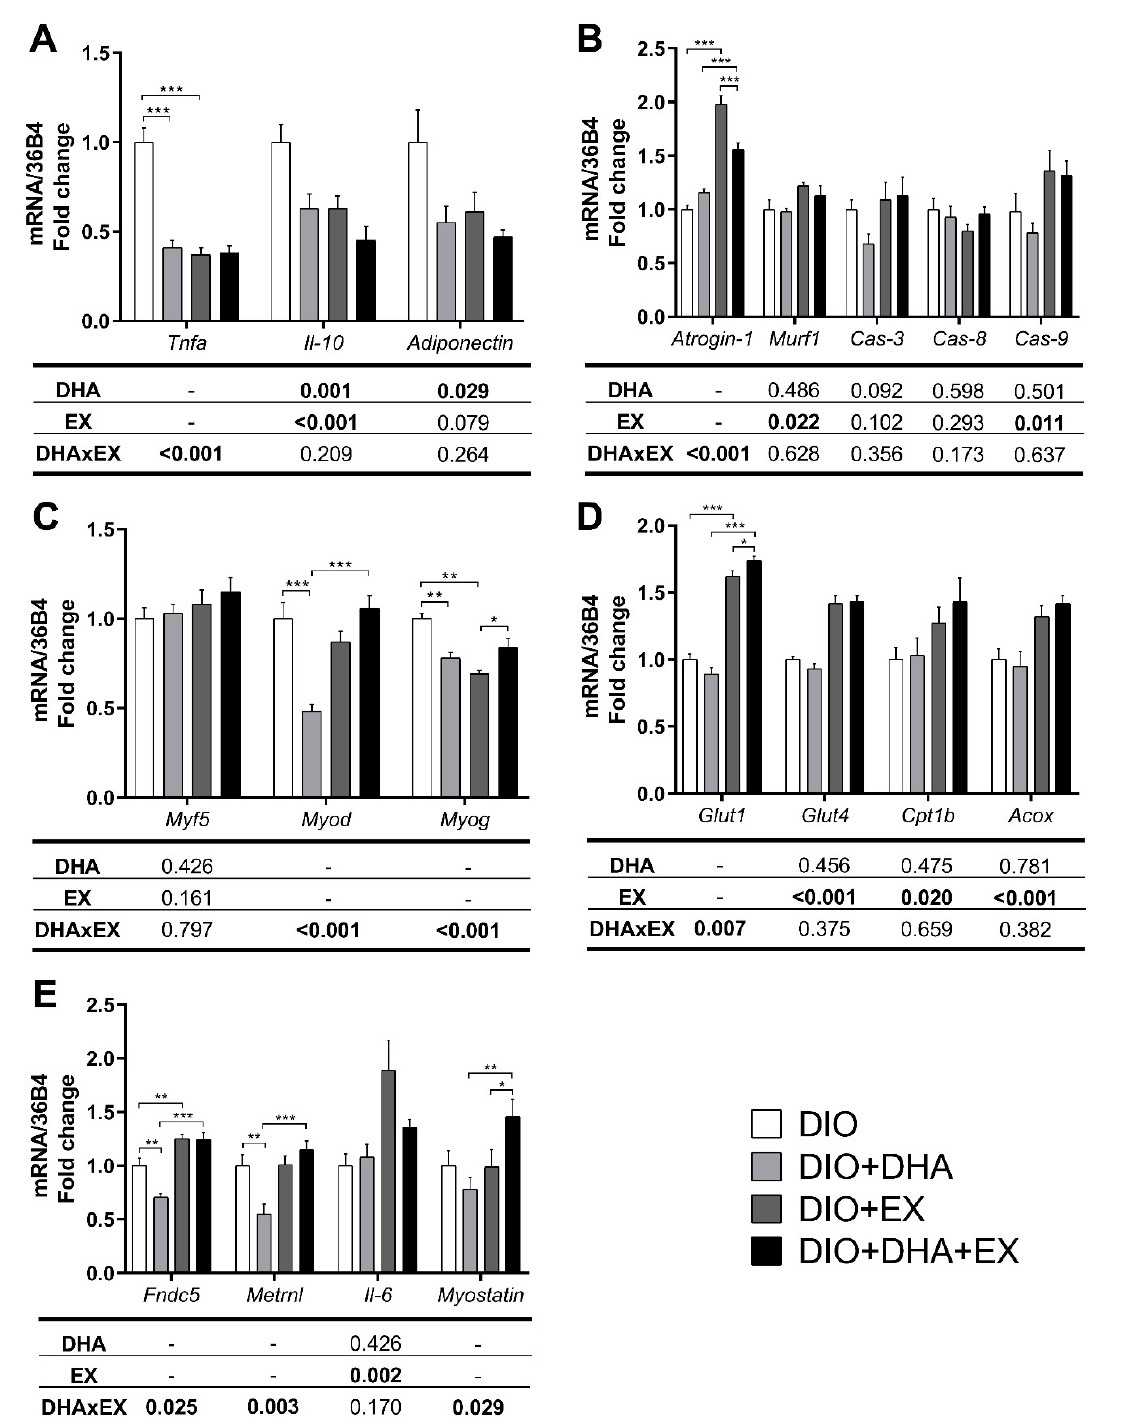
Figure 3. Effects of long-term DHA supplementation and/or exercise training on genes related to inflammation ( A ), muscle damage ( B ), muscle regeneration ( C ), glucose uptake and fatty acid oxidation ( D ) and myokine expression ( E ) in the gastrocnemius muscle of 18-month-old DIO female mice. Data presented as mean (SD); n = 6–10. DIO: Diet-induced obese; EX: Treadmill training. For two-way ANOVA, when an interaction was found, contrast analysis was performed. The p values for the main factors, DHA supplementation (DHA), exercise (EX) and the interaction between both (DHAxEX) are shown in the corresponding rows of the tables below the figures. Statistically signif- icant p values are marked in bold. Significant differences between groups are shown above the cor- responding comparisons: * p < 0.05, ** p < 0.01, *** p < 0.001.